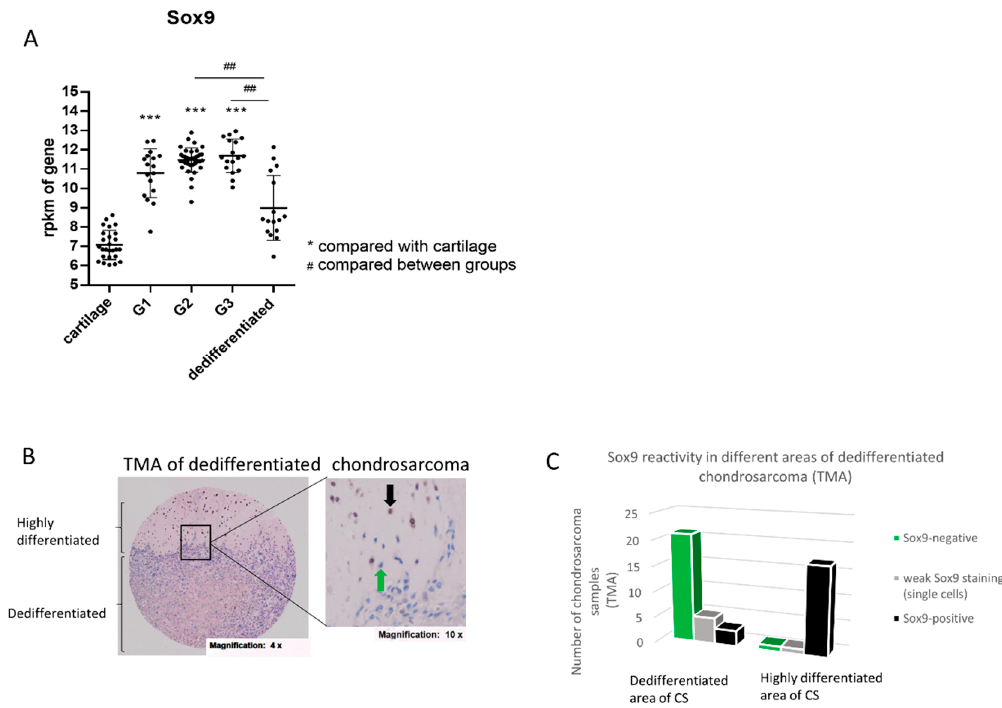
Figure 1. SOX9 expression in the chondrosarcoma samples. ( A ) Meta-analysis of SOX9 gene expression in human chondrosarcoma with different grades (G1, G2, G3) and in dedifferentiated chondrosarcoma, in comparison to SOX9 gene expression in healthy cartilage (from non-tumorous cartilage tissue). ( B ) Immunohistochemical (IHC) staining of SOX9 was performed on a tissue-micro-array (TMA) containing dedifferentiated chondrosarcoma. Representative image of nuclear staining intensity for SOX9 in chondrosarcoma tissue is shown. The black arrow indicates a SOX9-positive cell and the green arrow indicates a SOX9-negative cell. ( C ) Distribution of SOX9 reactivity in different areas of dedifferentiated chondrosarcoma samples in a TMA reveals a majority of SOX9-negative samples (21/29) in the dedifferentiated part of the tumor tissue and a majority of SOX9-positive samples (17/19) in the highly differentiated samples. rpkm = reads per kilo base per million mapped reads; G = grade; CS = chondrosarcoma; ## p ≤ 0,01; *** p ≤ 0.001.